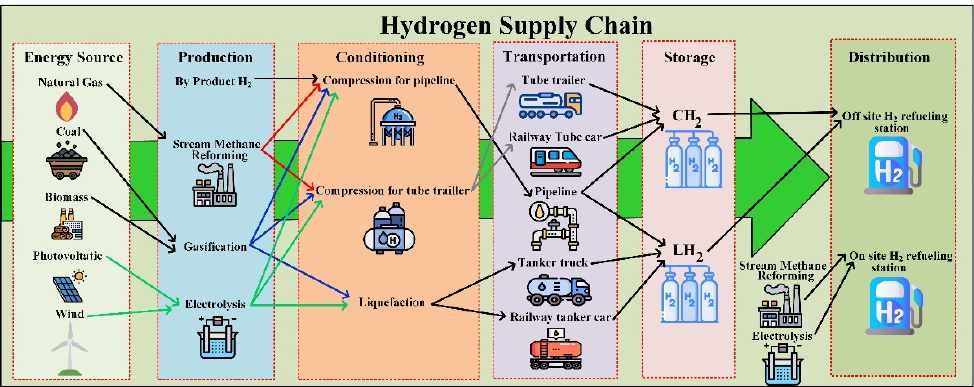
Figure 5. Schematic diagram of the Hydrogen supply chain (inspired by [50]).